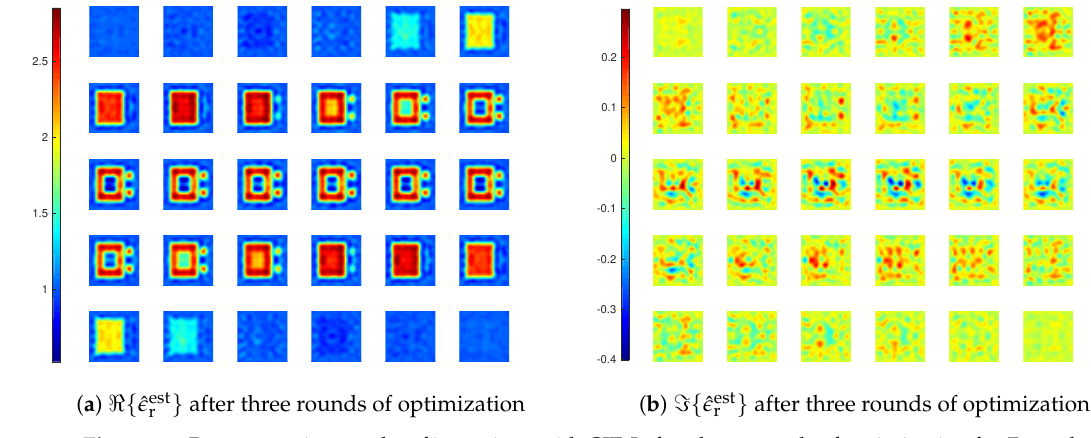
Figure 15. Reconstruction results of inversions with CIE-I after three rounds of optimization for Example 3 . In the first round, β 1 = β 2 = 6 and M F = 4. In the second round, β 1 = β 2 = 1 and M F = 8. In the third round, β 1 = β 2 = 0.5 and M F =